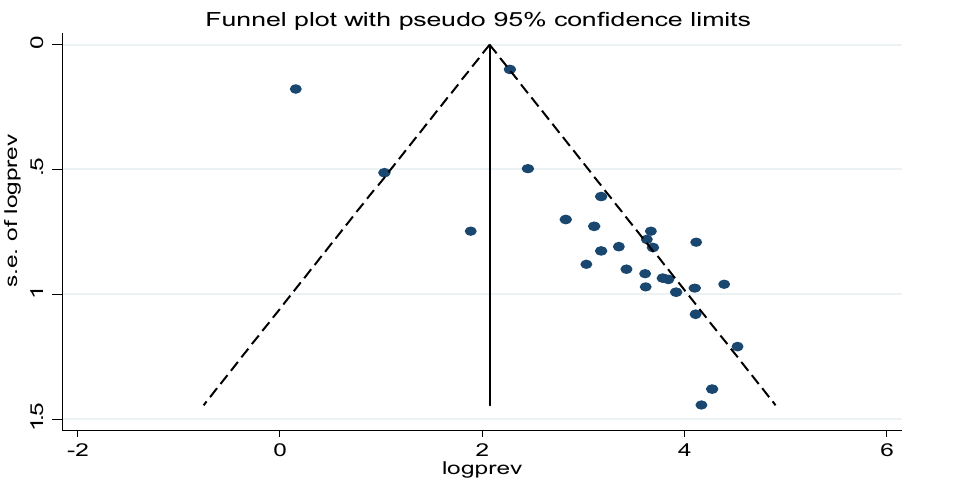
Figure 3. Funnel plot of the meta-analysis containing 27